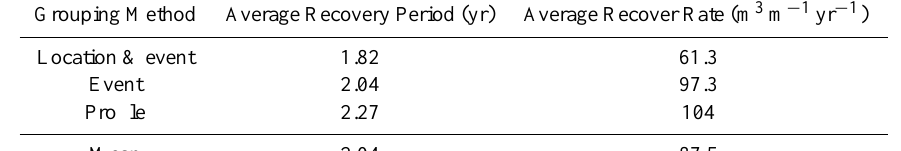
Table 3. Area recovery periods and recovery rates.